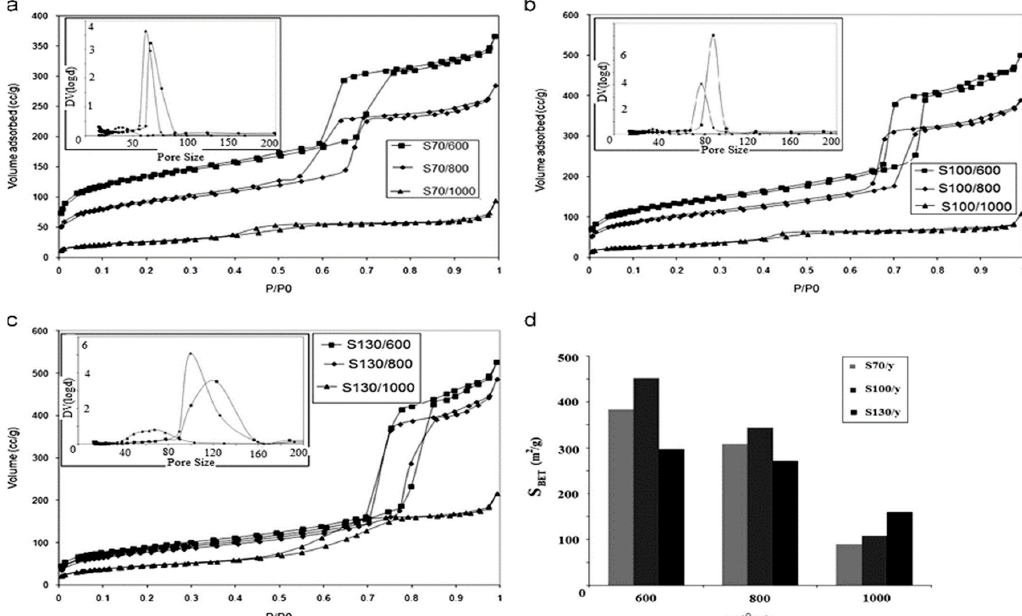
Figure 4. ( a – c ) BJH (Barrett–Joyner–Halenda) pore size distribution of the samples under